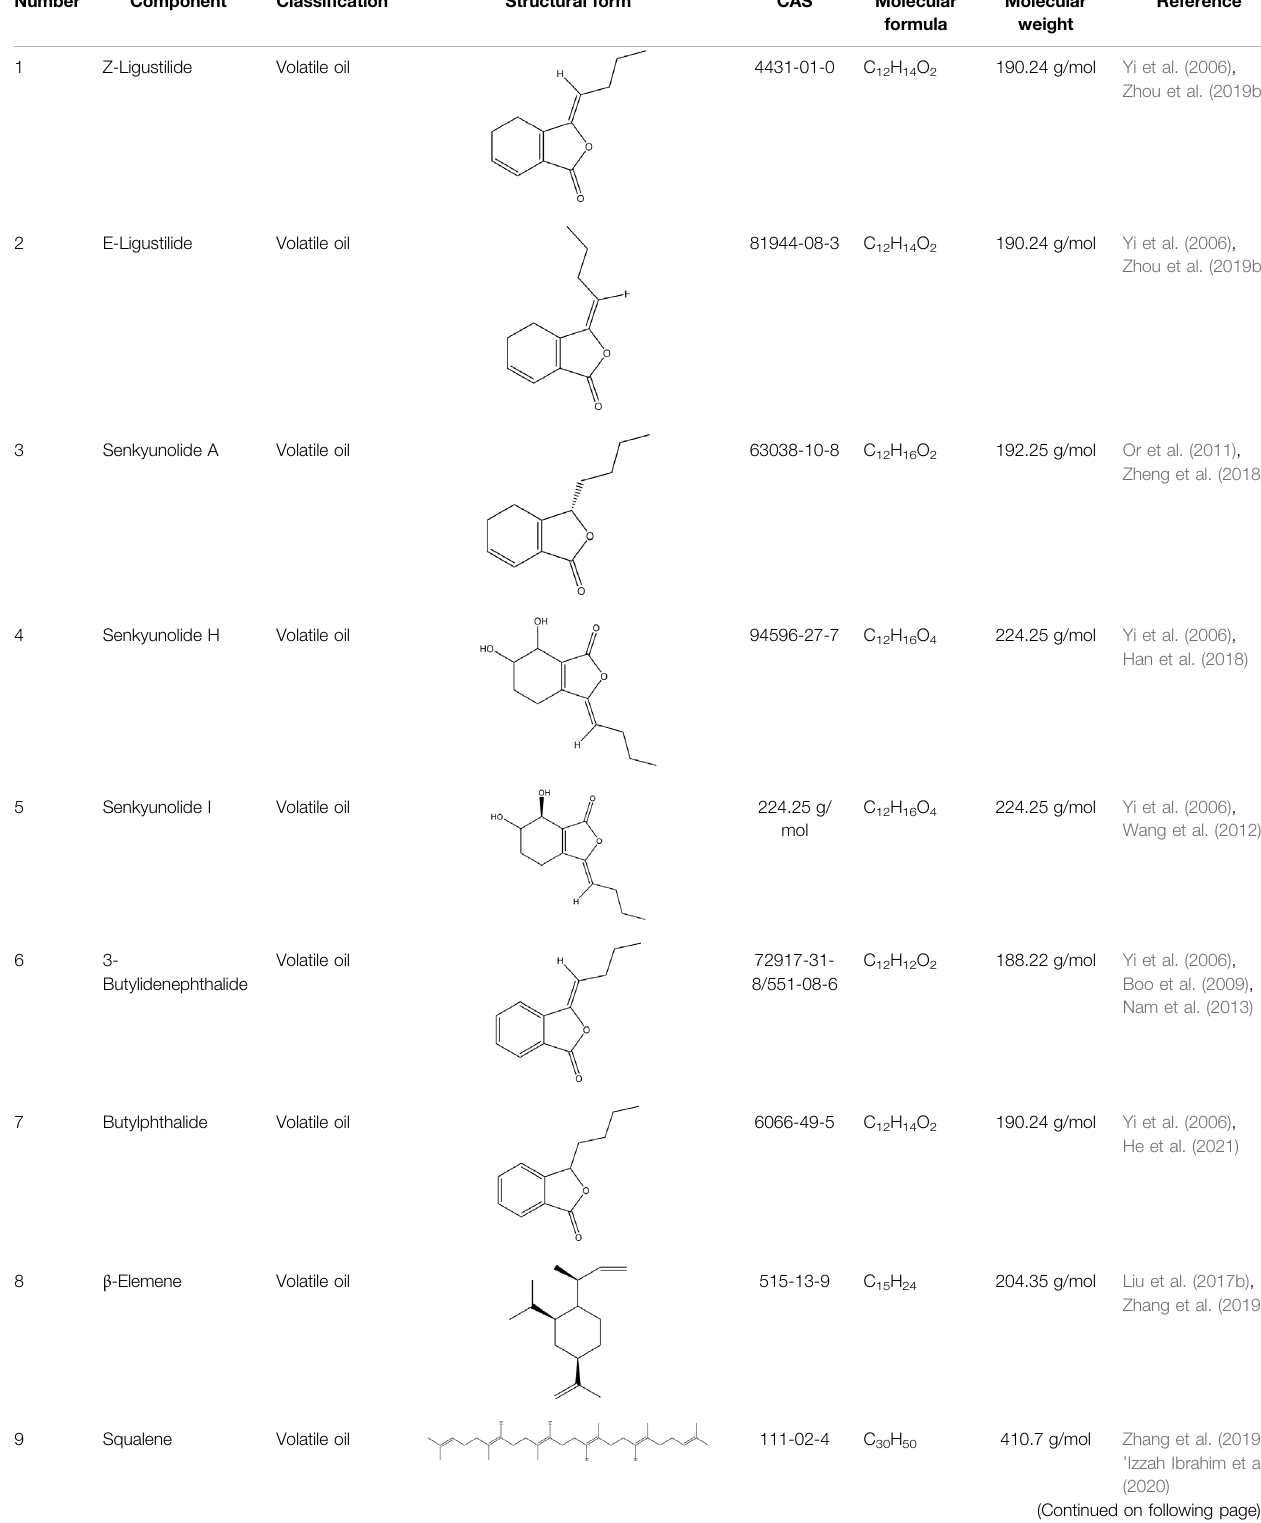
TABLE 1 | The pharmacodynamic material basis of Ligusticum chuanxiong Hort. in the treatment of